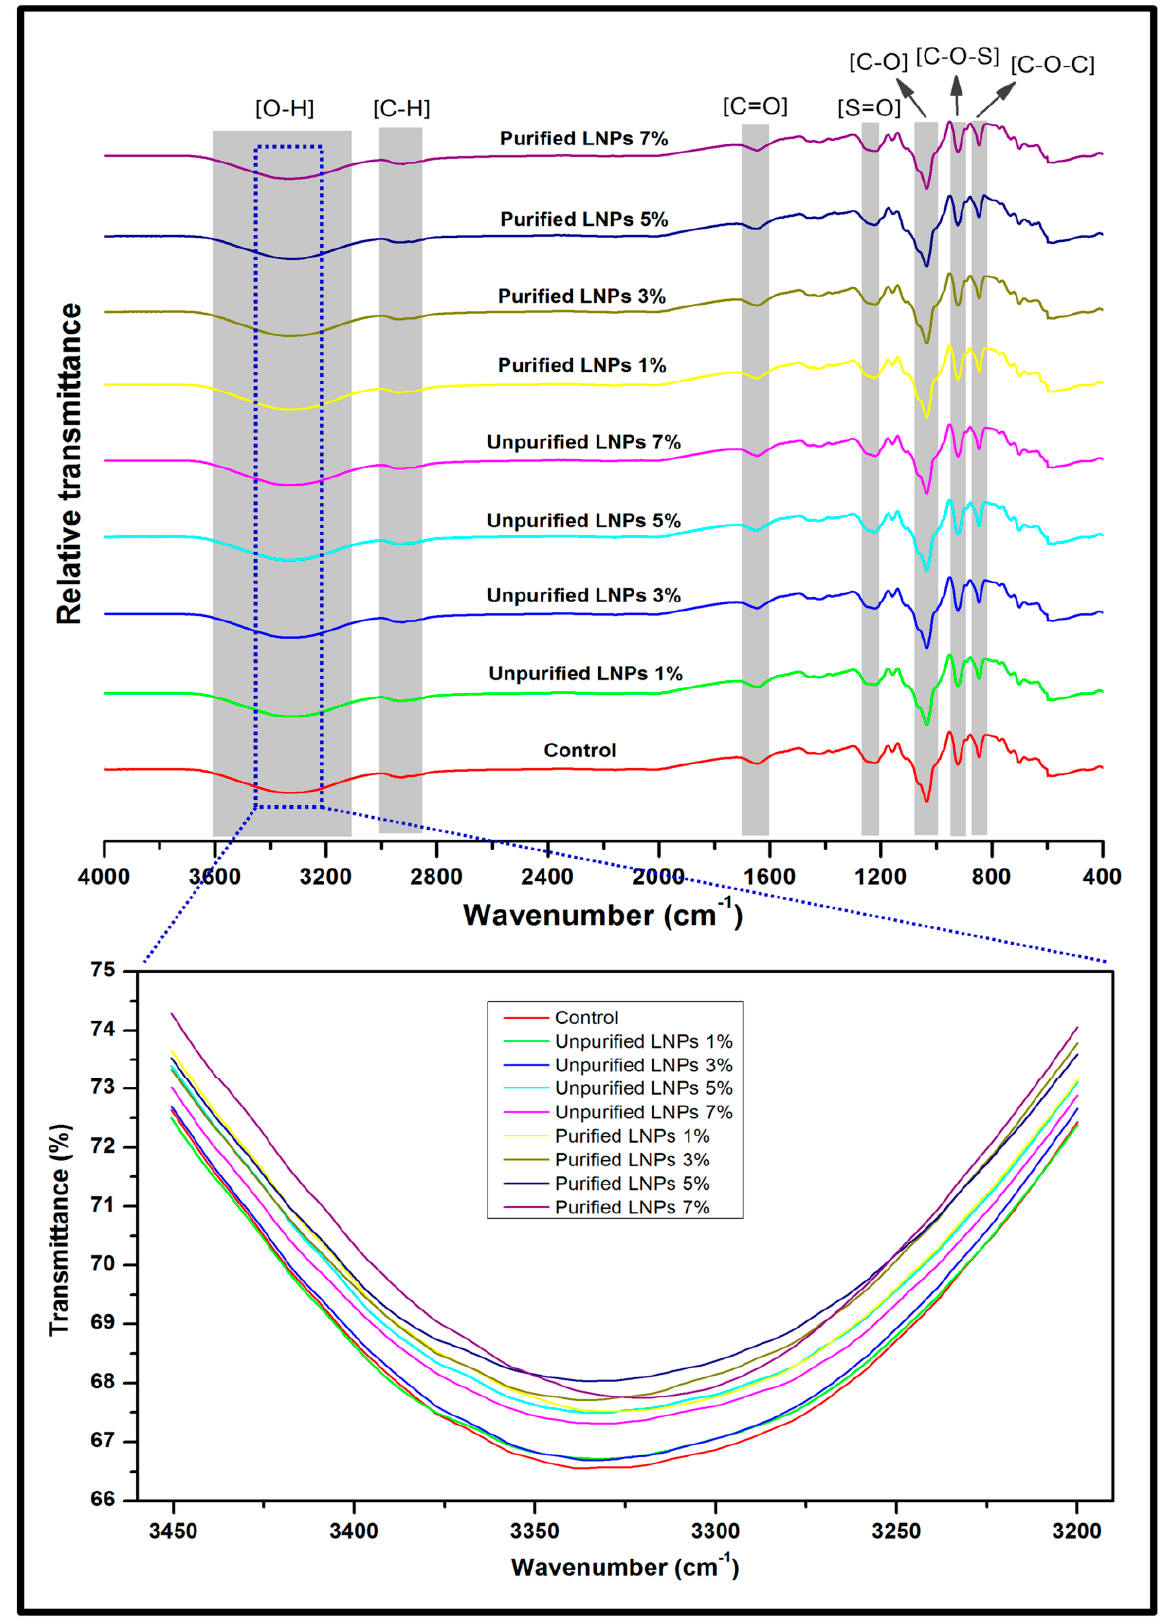
Figure 3. FT-IR spectra of control biopolymer film and bioplastic films reinforced by unpurified/purified LNPs.